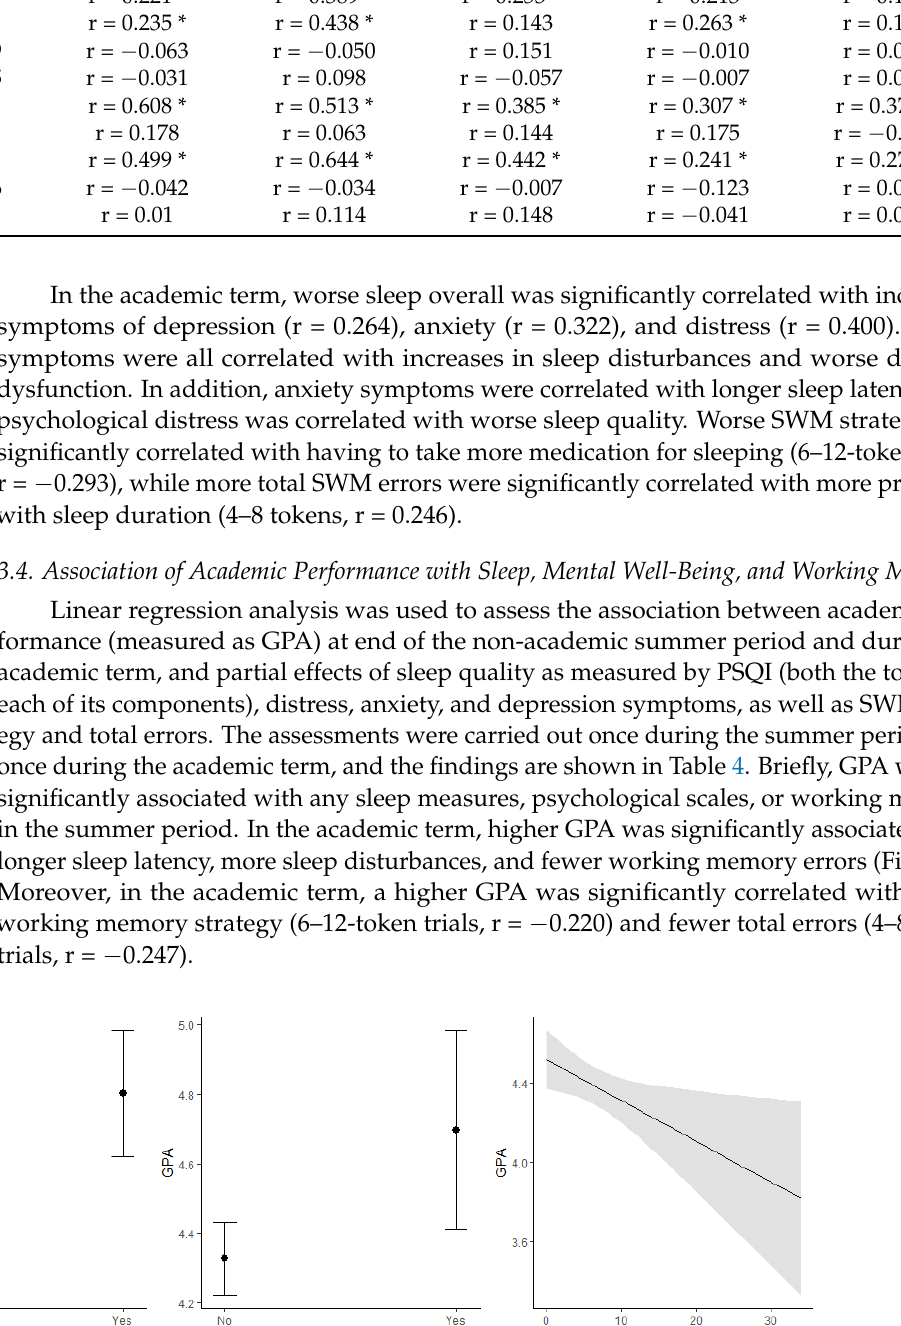
Table 3. Correlations between psychological scales, social media use, working memory, and PSQI components. Asterisks (*) indicate significance ( p < 0.05).